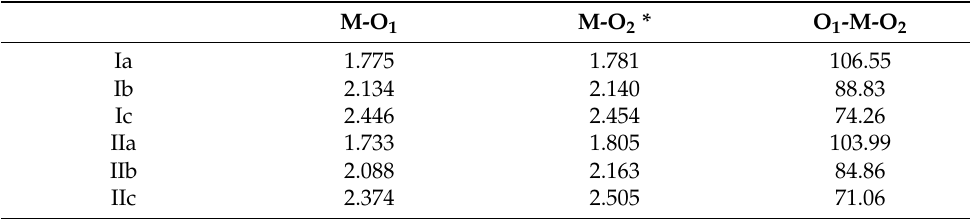
Figure 1. The optimized structure of the complexes of phenyldecane-1,3-dione ( I ) and isopropyl salicylate ( II ) with alkali metals ( a —Li; b —Na; c —K) obtained by DFT/B3LYP/6-311 + G (d, p). Table 1. Bond lengths (Å) and angles ( ◦ ) in six-membered metallacycles Ia-c and